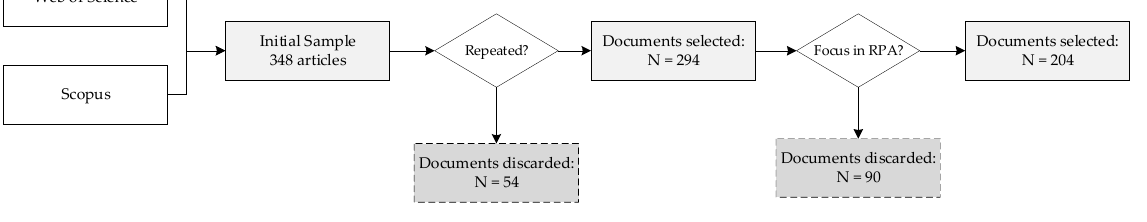
Figure 2. Article selection process.